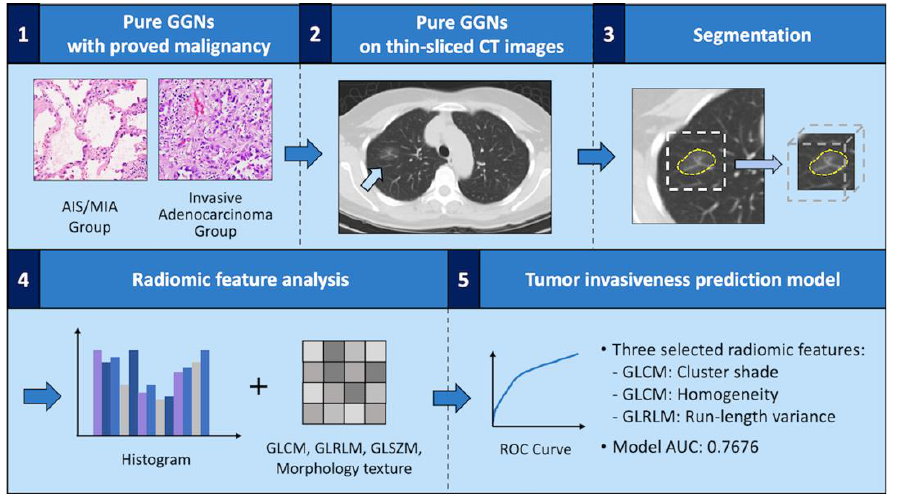
Figure 2. The framework of the tumor invasiveness prediction model for pure ground-glass nodules (pGGNs) lung adenocarcinoma. Summary of the radiomic analysis procedure: The steps involved in radiomics: ( 1 ) select patients with proven lung adenocarcinoma whose computed-tomography (CT) images were presented as pGGNs; ( 2 ) select patients with thin-sliced CT images; ( 3 ) segment tumor part in thin-sliced CT images; ( 4 ) extract radiomic information; ( 5 ) build a prediction model using extracted radiomic values and evaluate its